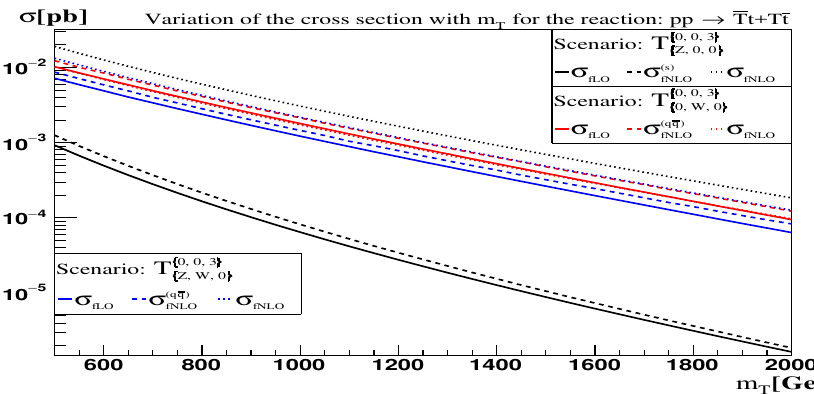
Figure 3 . Variation of the fLO and fNLO cross sections in term of the top partner mass for the three benchmark scenarios: T f 0 ; 0 ; 3 g